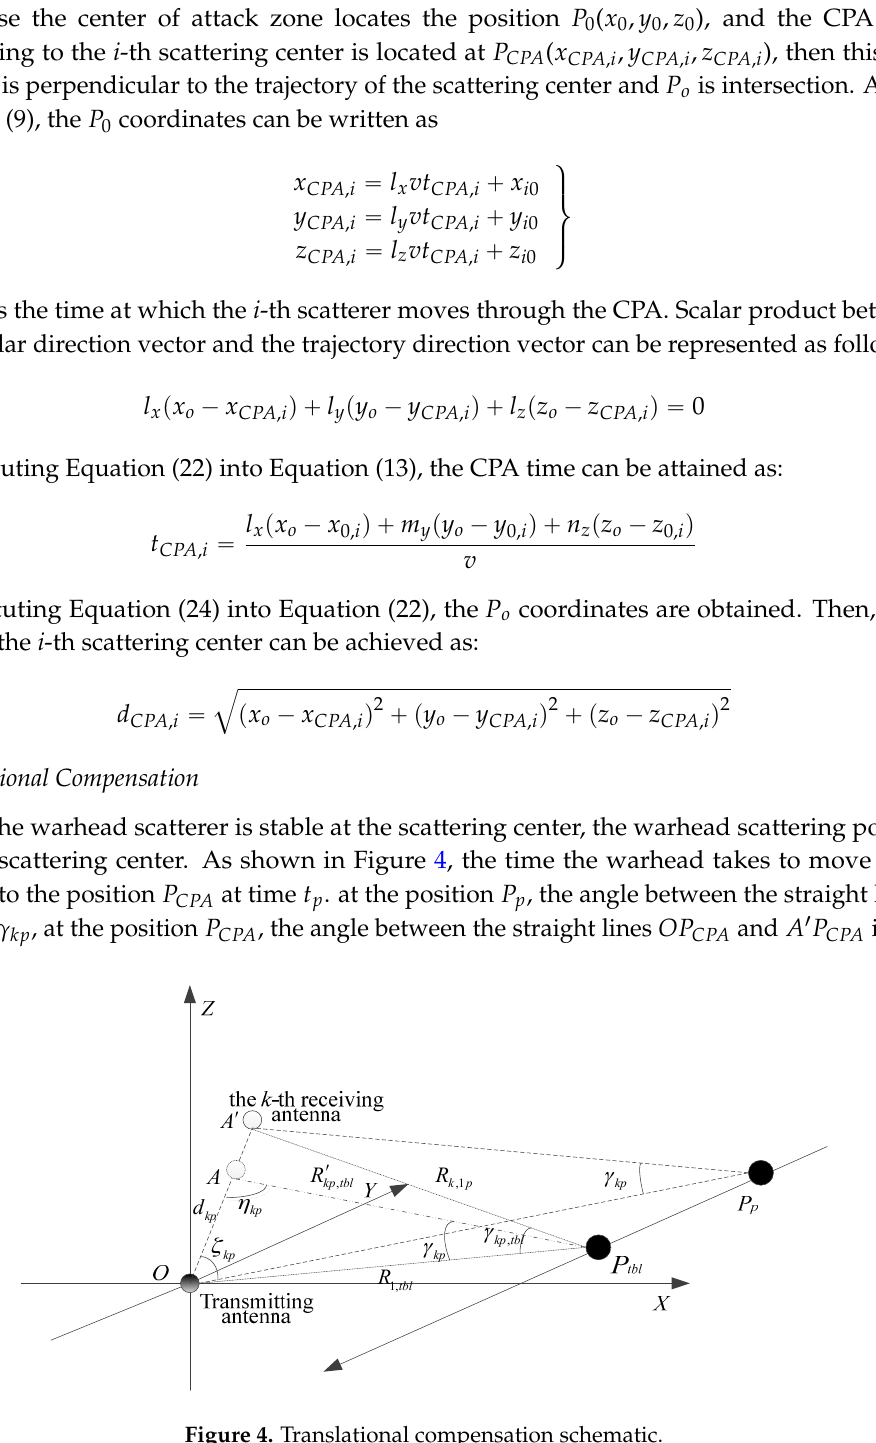
Figure 4. Translational compensation schematic.